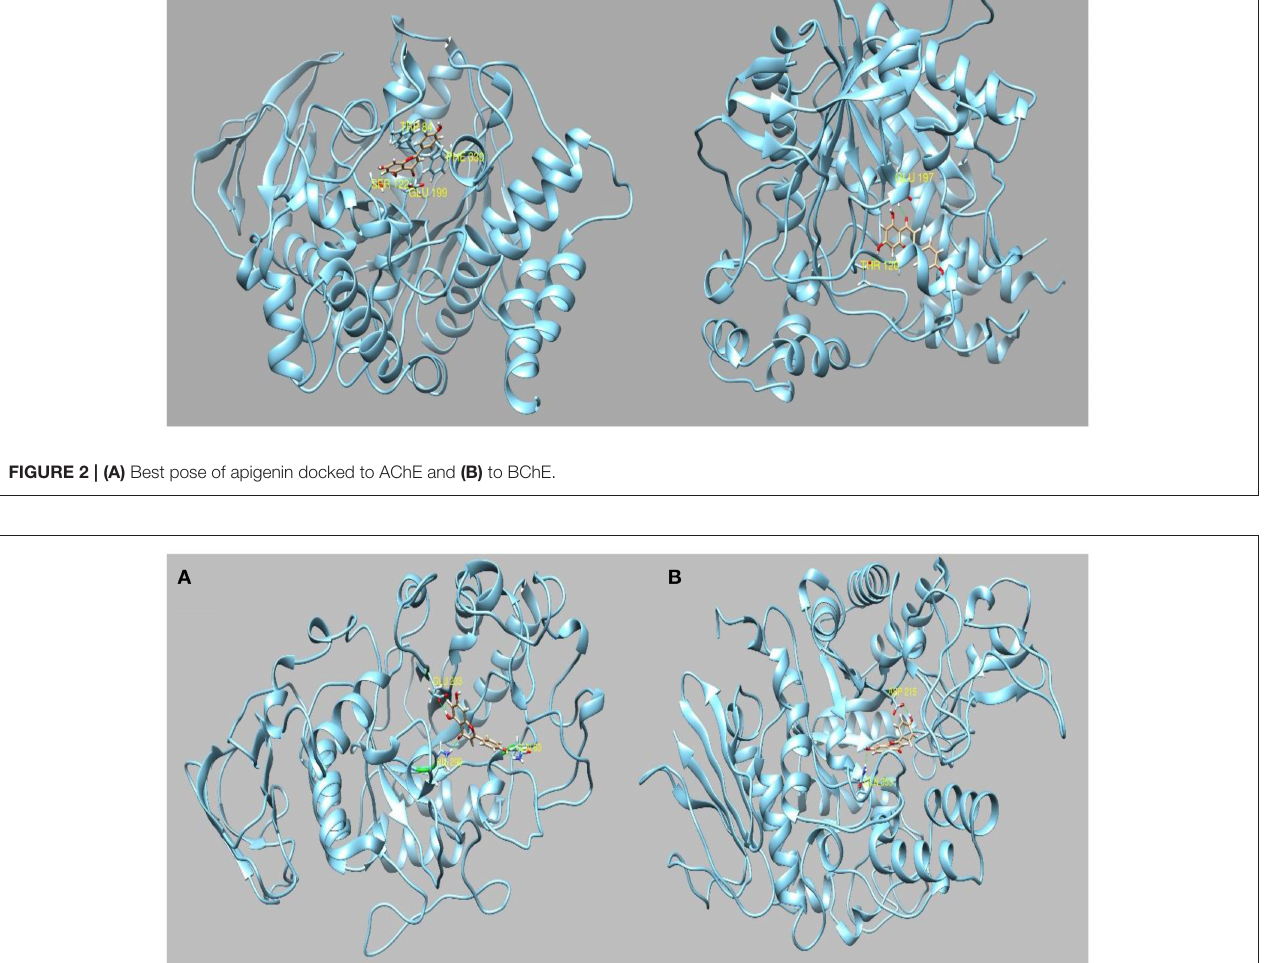
Frontiers in Pharmacology |